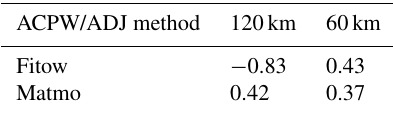
Table 4. The similarities of CNOPs gained from the ACPW and ADJ